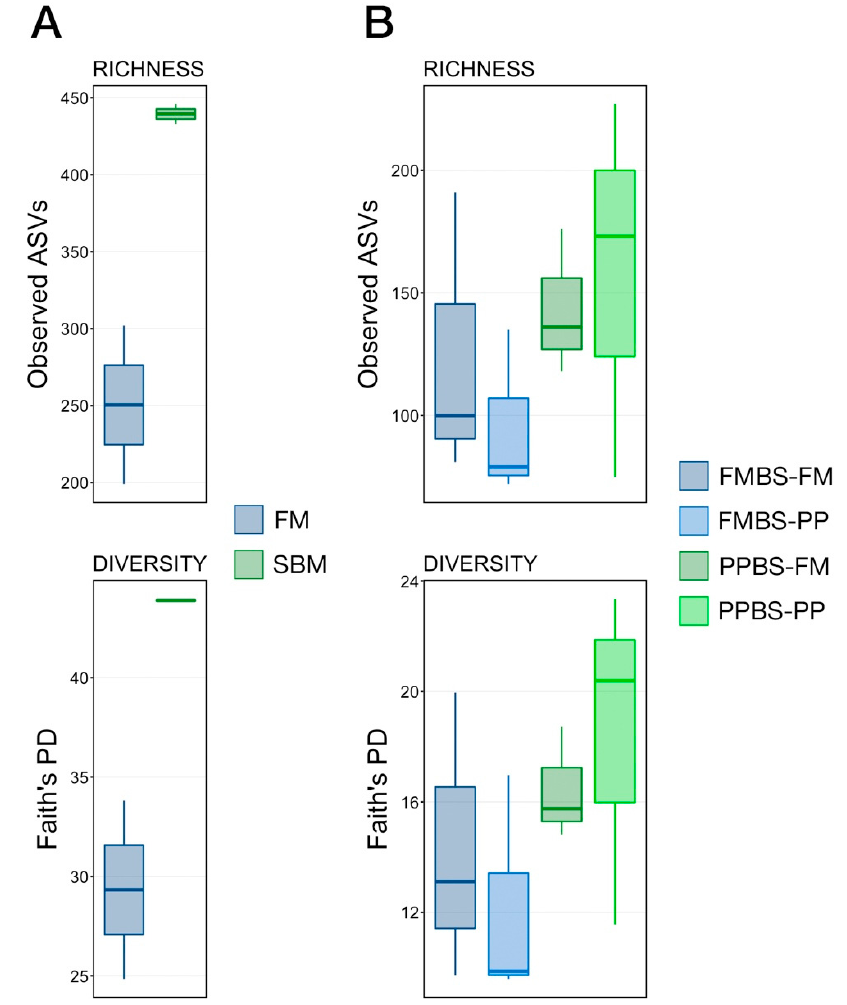
Figure 2. Boxplots demonstrating the richness (Observed ASVs) or diversity (Faith’s phylogenetic distance) of larval fish at 3 dph ( A ) or progeny adult fish at 48 dph ( B ). There were no statistical differences detected. Abbreviations: dph, days post hatch; FM, fishmeal broodstock; SBM, soybean meal broodstock; FMBS-FM, fishmeal broodstock with fishmeal programming; FMBS-PP, fishmeal broodstock with soybean meal programming; PPBS-RM, soybean mean broodstock with fishmeal programming; PPBS-PP, soybean meal broodstock with soybean meal programming.